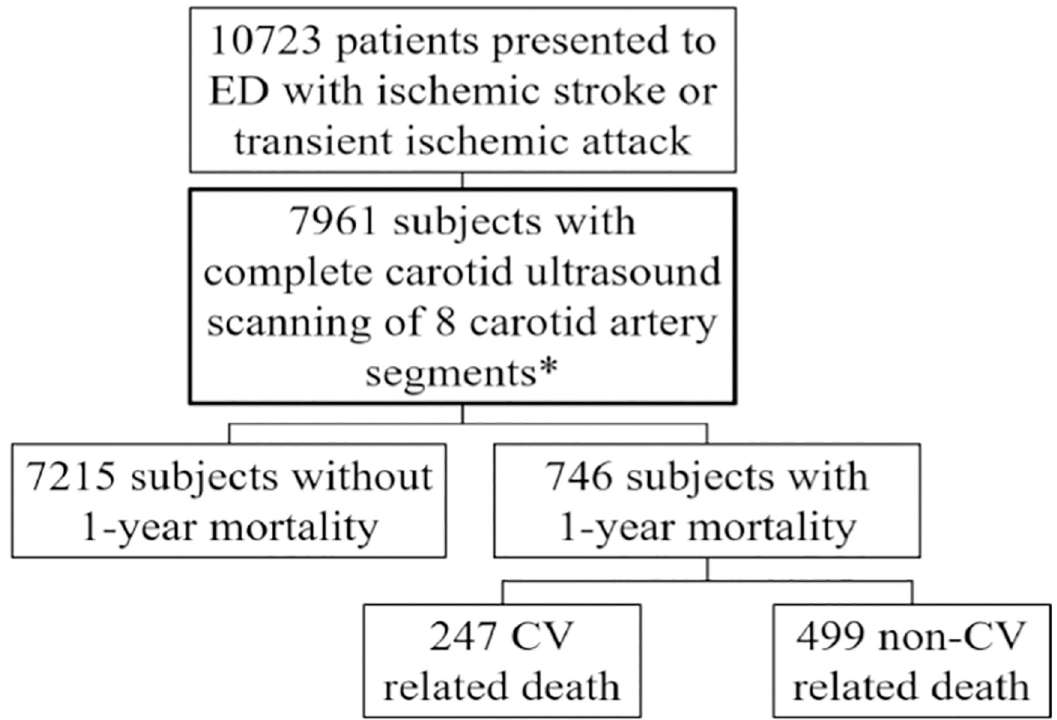
Fig 1. Flow chart of included patients. CV = cardiovascular, ED = emergency department. � Include carotid bulb, common carotid artery, internal carotid artery and external carotid artery of both sides.